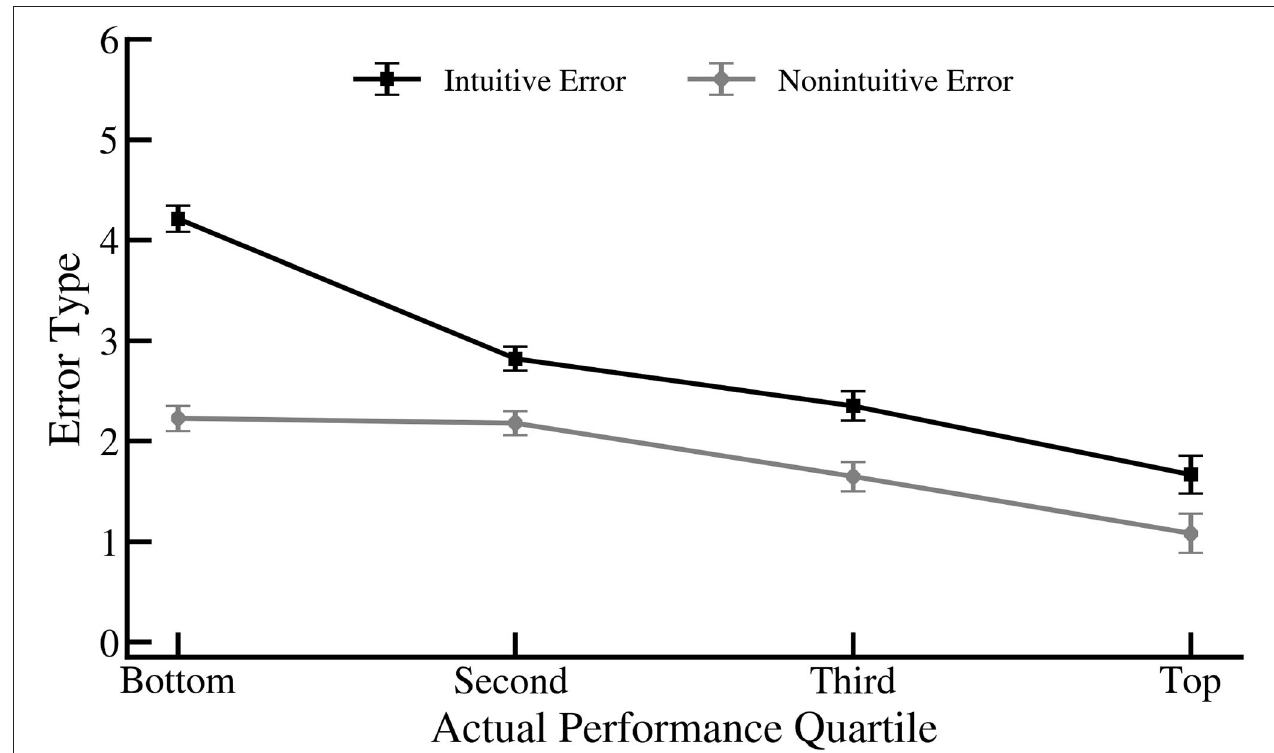
FIGURE 2 | The average number of intuitive and non-intuitive errors for each performance quartile. Error bars indicate standard